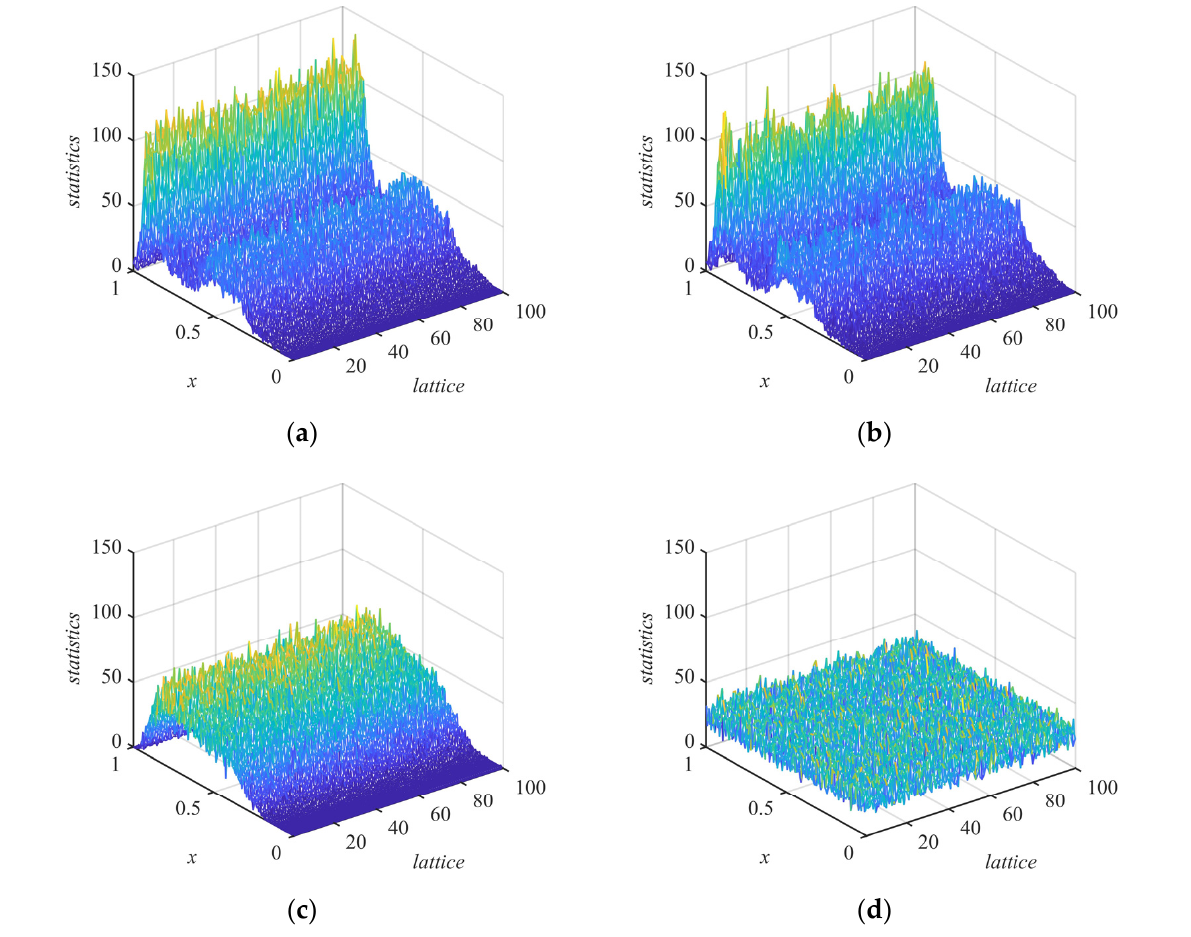
Figure 8. Distribution of sequences generated by the ( a ) 2D-CML, ( b ) 2D-NLCML, ( c ) 2D-MCPML and ( d ) 2D-DPRCML at ε = 0.375, μ = 4.